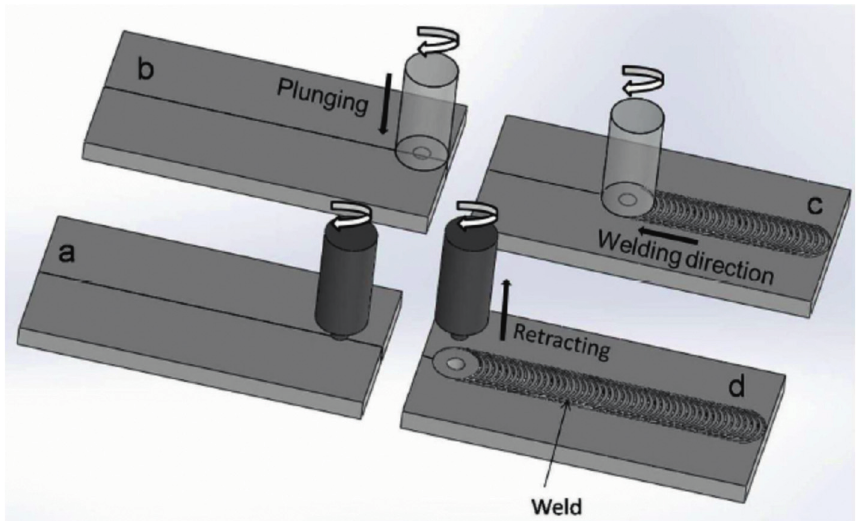
Figure 1: Steps of friction stir welding process.